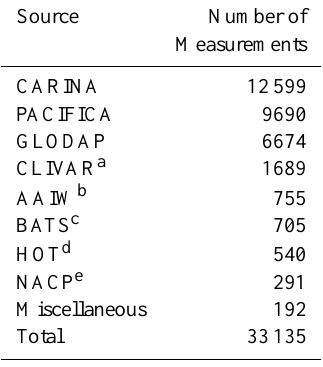
Table 2. Data sources of our global merged